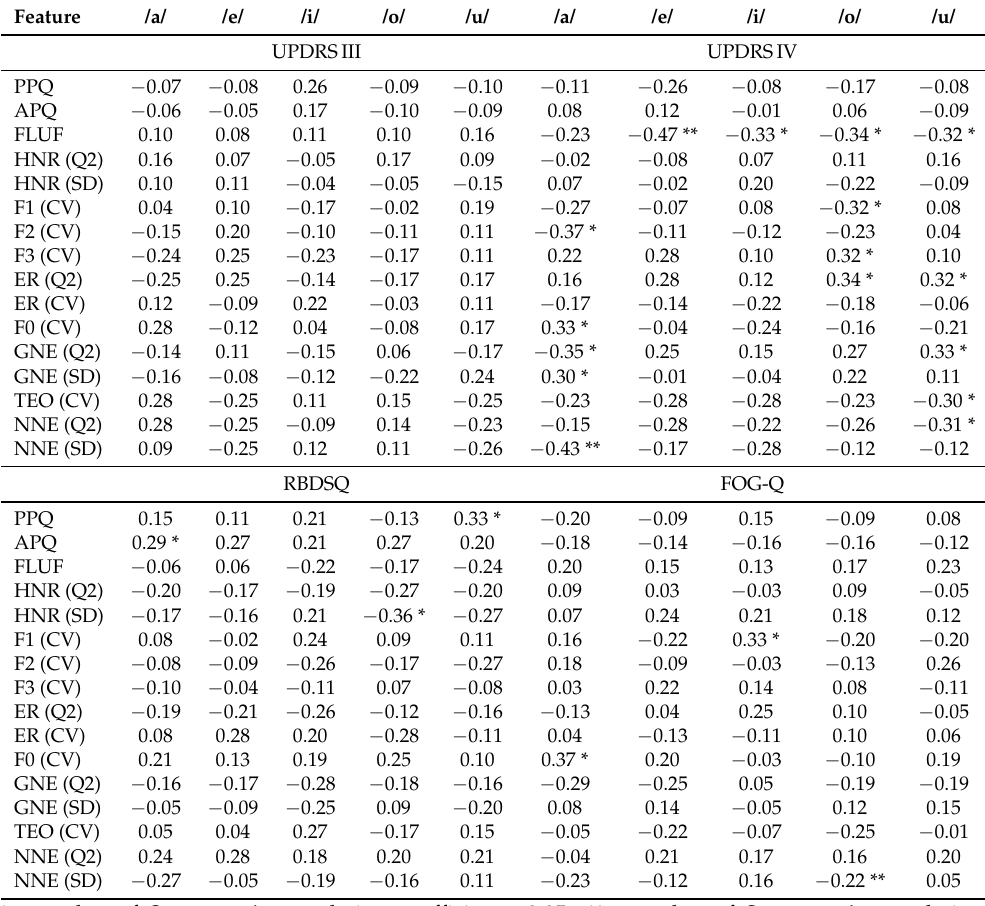
Table 3. Spearman’s correlation coefficients between baseline acoustic features and ∆ of clinical